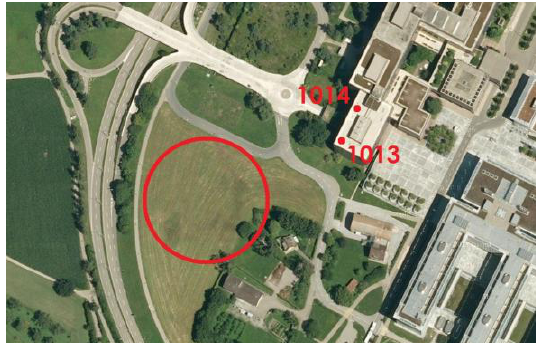
Figure 4. Overview of the data acquisition area. The red circle signalizes the aviation area while the red dots point on the positions of the reference station.